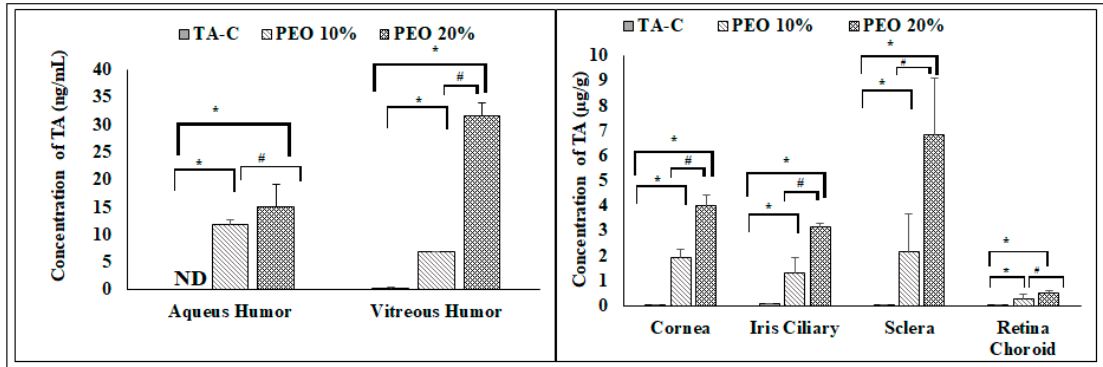
Figure 4. In vivo ocular distribution of triamcinolone acetonide from 10% and 20% w / w PEO films and TA-C in ocular tissues (mean ± SD, n = 3). *, # indicates p < 0.05 statistically significant of 20% PEO TA-films when compared to TA-C and 10% PEO TA-films, respectively. ND—not detected.